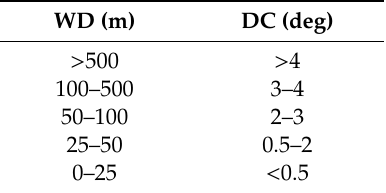
Table 3. Normalization criterion used for water depth (WD) and distance to coast (DC) indices related to cost factors.